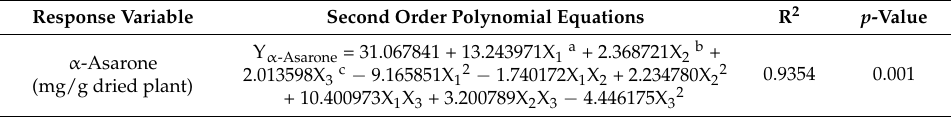
Table 4. Polynomial equations calculated using the RSM program for extraction conditions. Response Variable Second Order Polynomial Equations R 2 p